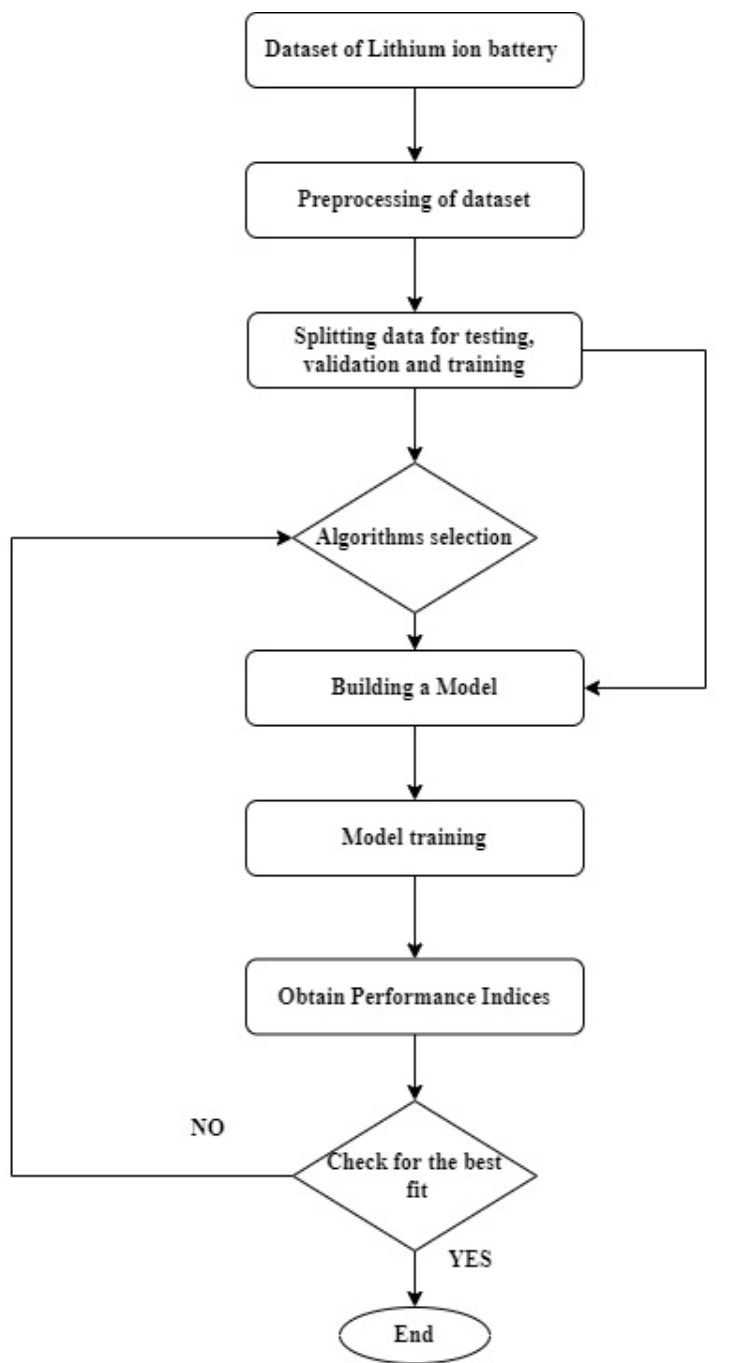
Figure 18. Flow chart for steps to follow to choose a best fit algorithm.